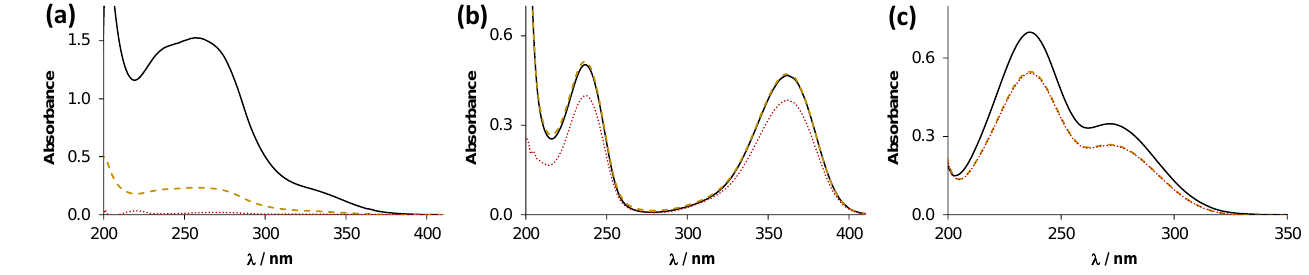
Figure 6. Absorption spectra of ultrafiltered ( a ) IMA, ( b ) FAVI and ( c ) MOLNU in the absence (dashed brown spectra) and in the presence of blood serum (red dotted spectra) plotted together with the non-filtered reference spectra (solid black line) [ c compound = 50 μM; 4 -fold diluted blood serum; pH = 7.4 (PBS); t = 25 °C]. The red dotted spectra are corrected by the absorption originating from the ultrafiltered blood serum.